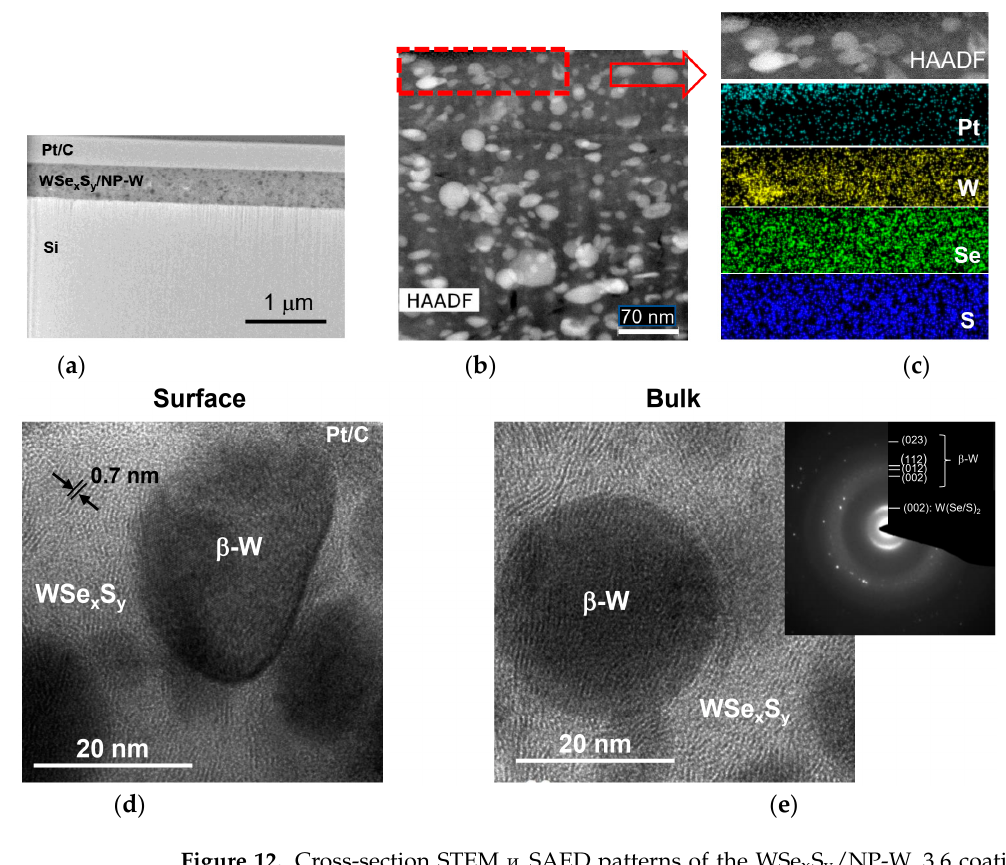
Figure 12. Cross-section STEM и SAED patterns of the WSe x S y /NP-W_3.6 coating subjected to tribotesting (500 cycles) in wet air at 1 N load on the counter body: ( a ) low-magnification TEM image of the coating; ( b ) HAADF STEM image of the coating; ( c ) the elemental maps obtained for a surface layer indicated in ( b ); and ( d , e ) HRTEM images obtained for ( d ) the surface and ( e ) deeper layers of the coating. The insert contains the SAED pattern which confirms the crystallization of the coating matrix.